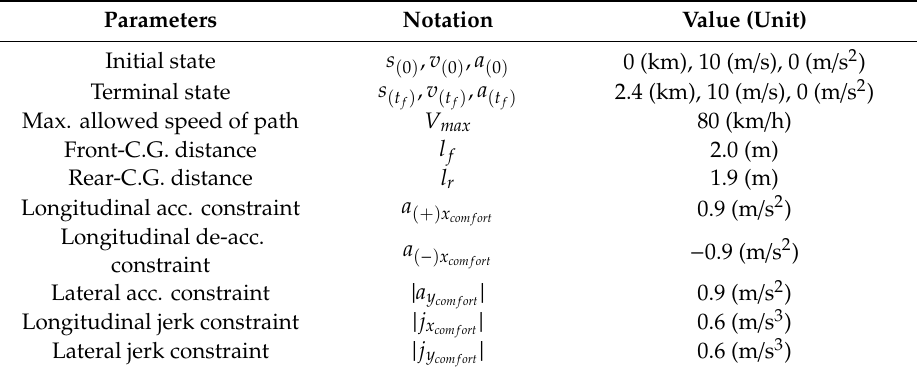
Table 1. Parameters for the software-in-the-loop (SIL)